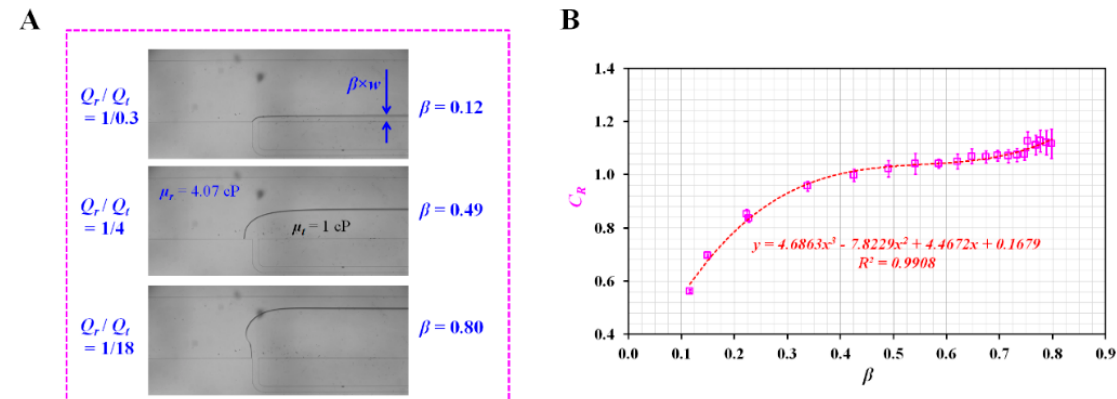
Figure A1. Experimental measurement of correction factor ( C R ). ( A ) Microscopic images showing the interfacial location ( β ) with respect to flow rate ratio of two fluids ( Q r / Q t ). The corresponding β for flow rate ratio ( Q r / Q t ) was obtained as β = 0.12 for Q r / Q t = 1/0.3, β = 0.49 for Q r / Q t = 1/4, and β = 0.8 for Q r / Q t = 1/18. ( B ) Variations of correction factor ( C R ) with respect to β . Linear regression analysis showed that C R was expressed as C R = 4.6863 β 3 − 7.8229 β 2 + 4.4672 β + 0.1679 ( R 2 = 0.9908).